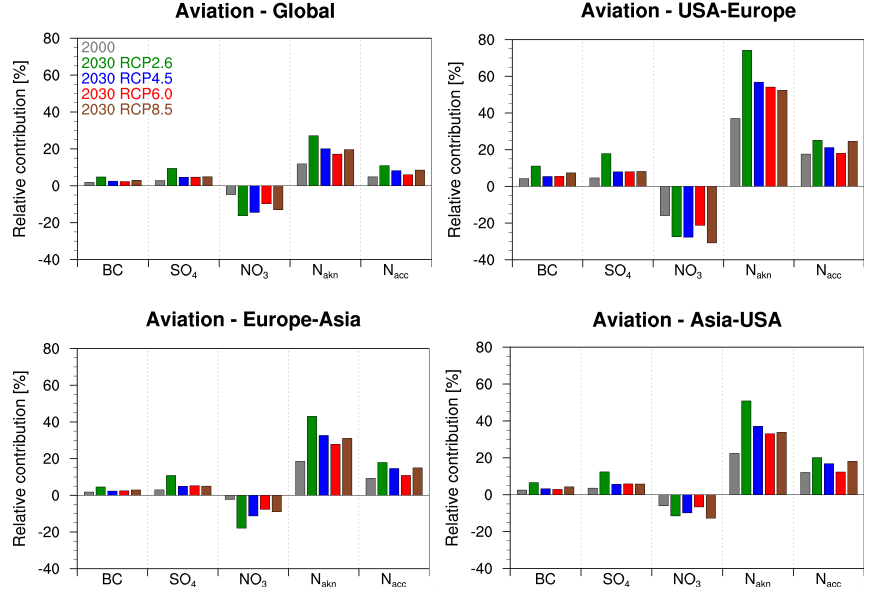
Figure 7. Relative contributions of aviation to the average mass and number burdens of selected aerosol species and different particle size modes (Aitken and accumulation mode). Results are shown for the year 2000 and for the four RCP scenarios in 2030. The values are integrated in model layers 7 to 9 ( ∼ 8–13km) globally and in three different regions (defined in Fig. 1).